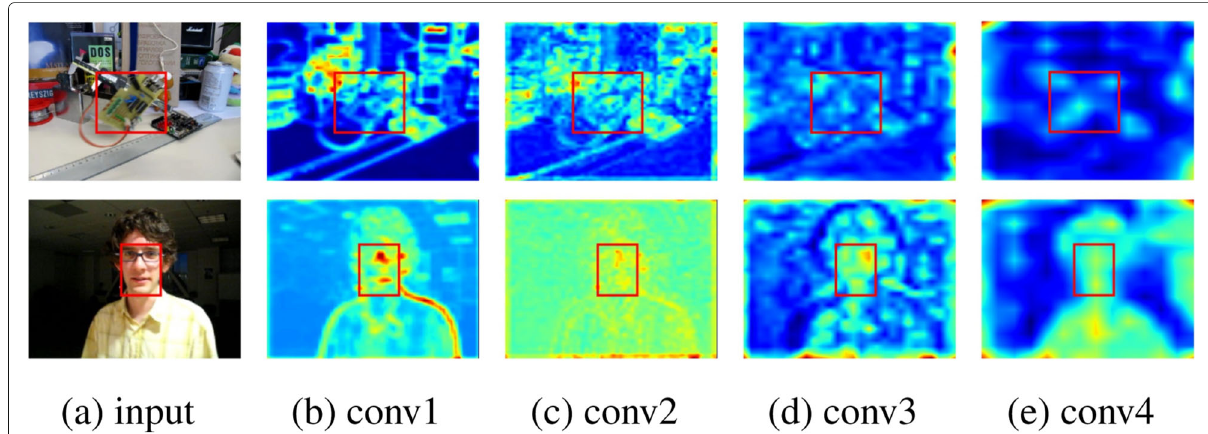
Fig. 2 Visualization of the features from ResNet. a Input frame. b – e Features are extracted on convolutional layers conv1, conv2, conv3, and conv4 of ResNet; their original spatial resolutions are 128 × 128, 56 × 56, 28 × 28, and 14 × 14, respectively. The red boxes indicate the tracking results by our